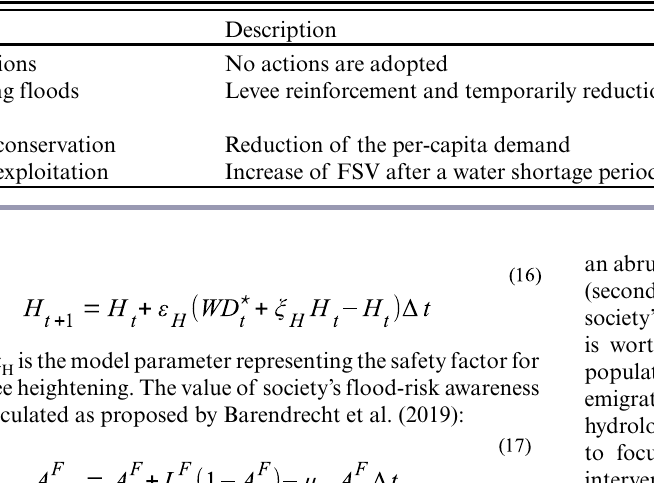
Table 1 . Summary of the different water-management strategies (WMS) used to test the capability of the proposed socio-hydrological model to capture the main human-water dynamics. Note: FSV = full supply